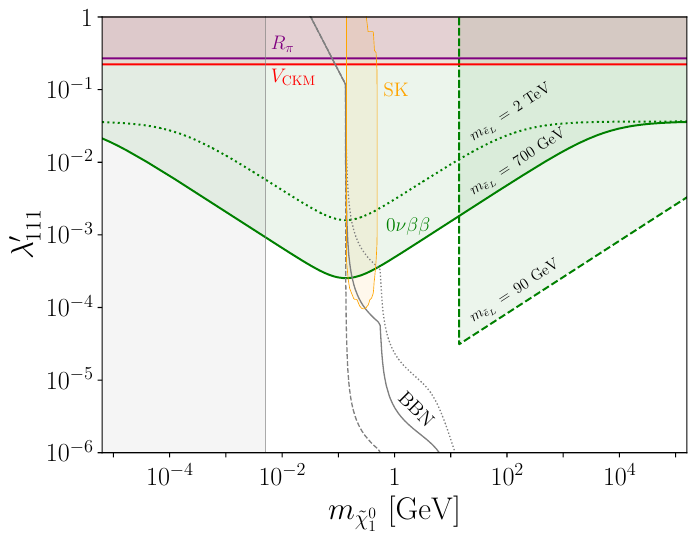
Figure 6 . Excluded regions in the ( λ 0 , m ) plane. The green regions are excluded from the ˜ χ 0 1 111 current lower limit on the 76 Ge 0 νββ decay half-life for m ˜ u = m ˜ = 1900 GeV and m ˜ g = 2350 GeV d R L and three different values of the selectron mass; m ˜ e = 700 GeV (solid), m ˜ e = 90 GeV (dashed) L L and m ˜ e = 2 TeV (dotted). The red and purple regions are excluded from measurements of V ud L and R π respectively. The orange region is excluded by the non-observation of ˜ χ 0 decays in Super- 1 Kamiokande, assuming λ 0 = λ 0 , m ˜ e = 700 GeV and m ˜ u = m ˜ = 1900 GeV. The regions to 112 111 d R L L the left of the solid and dashed grey lines are excluded by BBN, i.e. requiring the ˜ χ 0 lifetime to 1 be less than 1 second. The solid vertical grey line and shaded region applies for a gravitino mass m ˜ at the lower bound from L3, whereas the solid, dashed and dotted grey lines correspond to the ψ same three values of m ˜ e (and benchmark values of m ˜ u , m ˜ and m ˜ g ) as the 0 νββ decay limits, d R L L with m ˜ (cid:29) m ˜ e ψ L